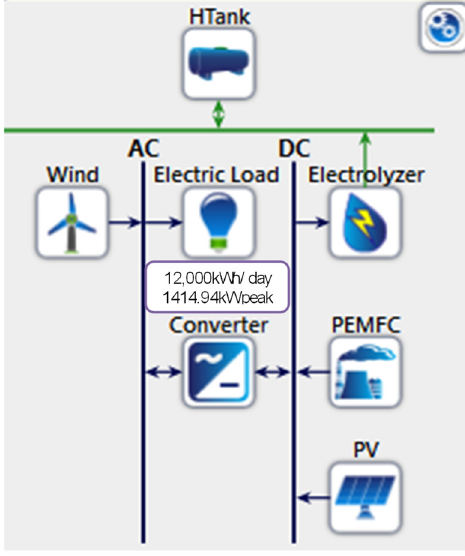
Figure 8. PV/FC/Wind hybrid power system.